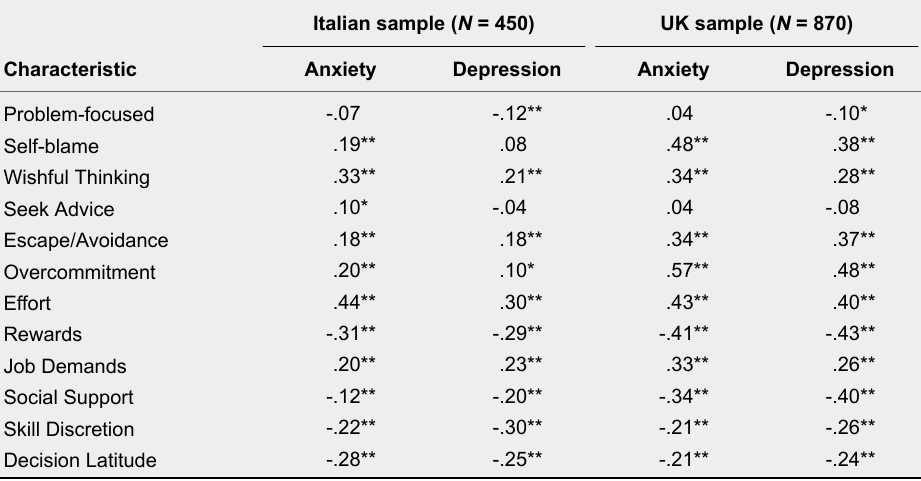
Correlations of Individual and Job Characteristics With Perceived Levels of Anxiety and Depression in Italian and UK Nurses Italian sample ( N = 450) UK sample ( N = 870) Characteristic Anxiety Depression Anxiety Depression Problem-focused Self-blame Wishful